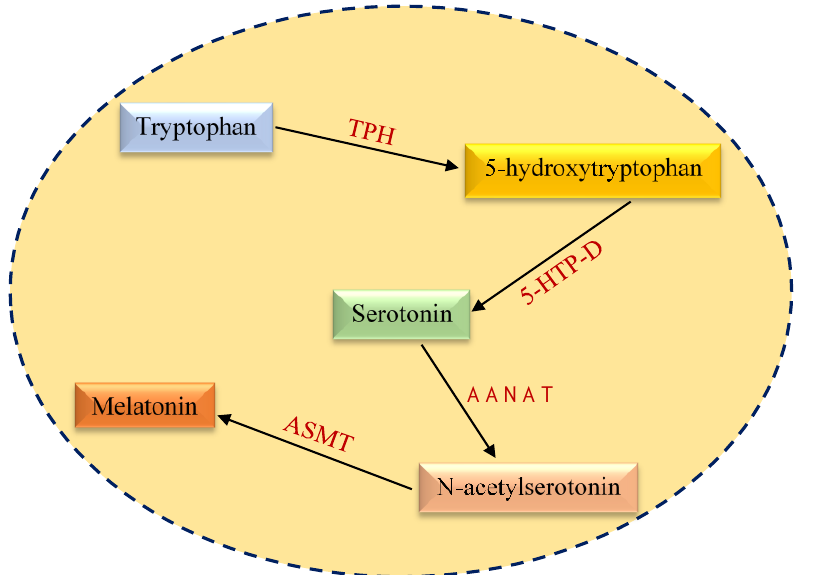
Figure 1. An overview of melatonin biosynthesis pathway. TPH, tryptophan hydroxylase; 5-HTP-D, 5-hydroxytryptophan decarboxylase; AANAT, arylalkylamine N-acetyltransferase; ASMT, acetylserotonin O -methyltransferase.